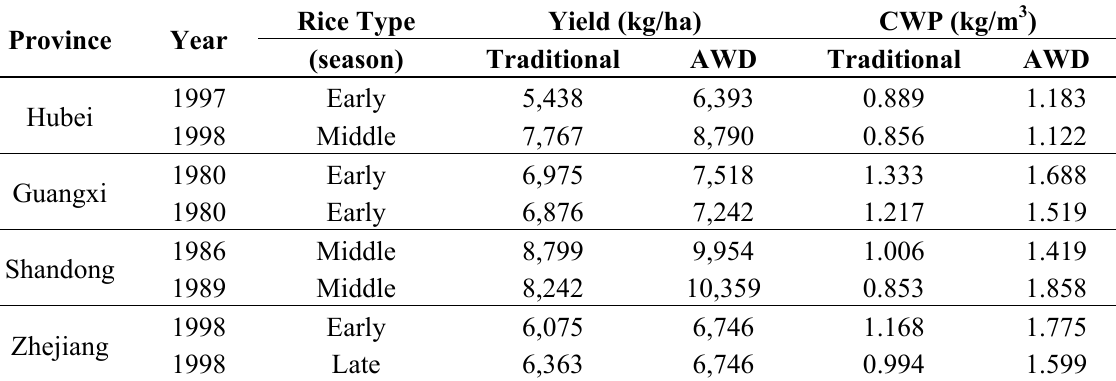
Table 4. Rice yields and estimates of farm-level water productivity for rice, irrigated with traditional methods and using alternate wetting and drying. Source: This table is reproduced from the paper by Li and Barker (2004)